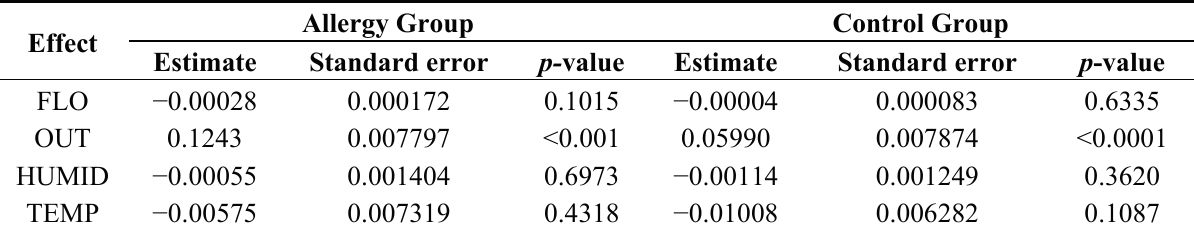
Table 5. The relationships of pollen concentration and time outside with total nasal symptom scores.